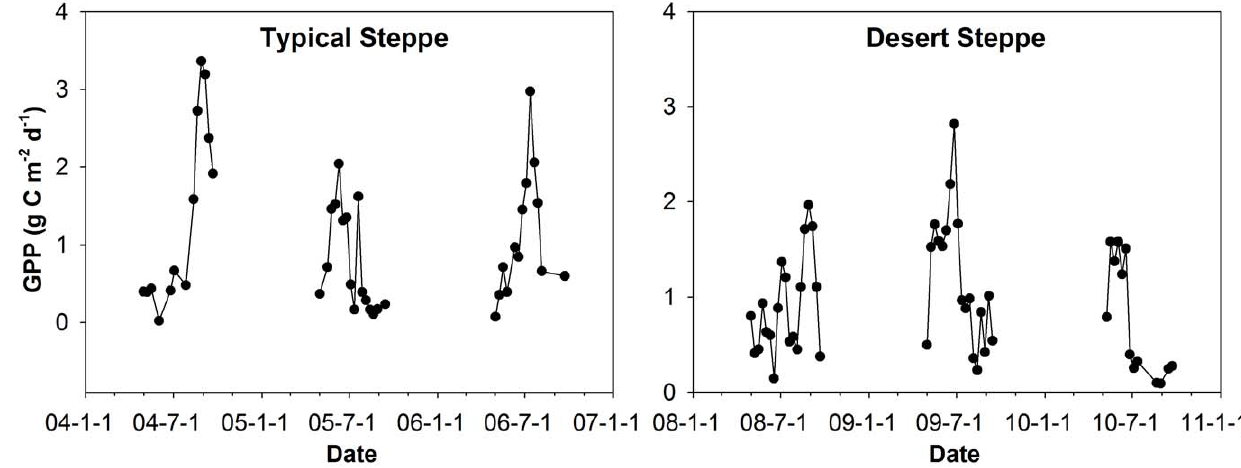
Figure 3. Seasonal variations of gross primary production (GPP) at the two sites. GPP was averaged for each 8-day period according to time stamp of MODIS FPAR. Only ‘‘good’’ GPP values (at most, 25% of half-hourly GPP values gap-filled) are shown.